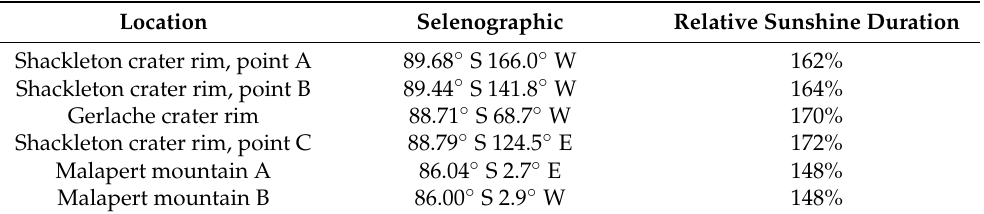
Table 2. Solar illumination conditions of the selected mountain peaks at the lunar south polar regions